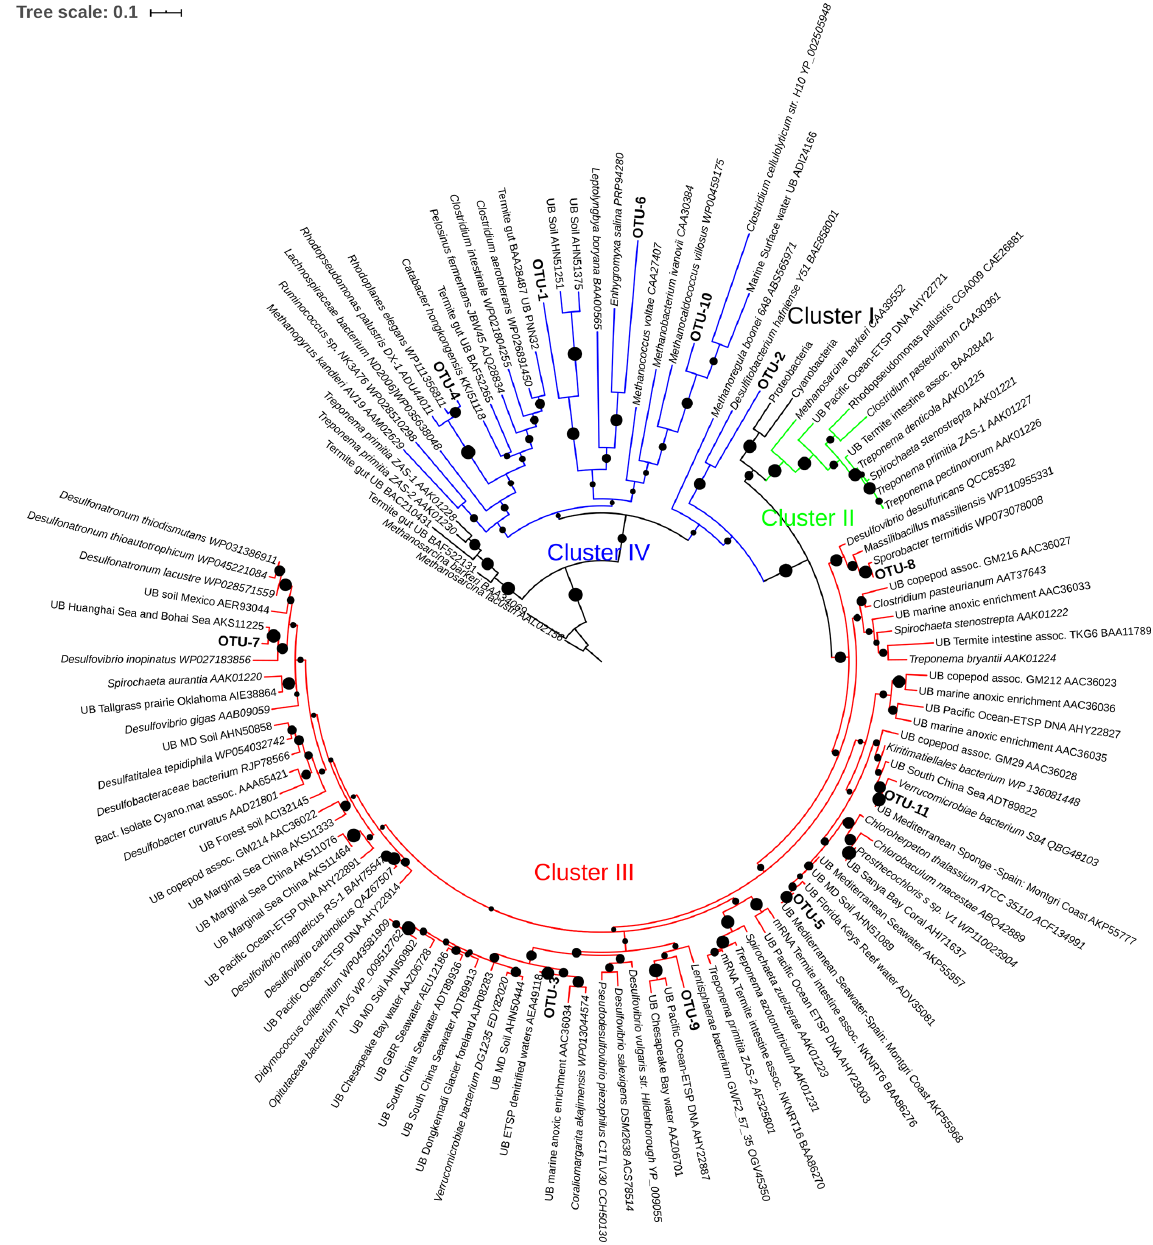
Figure 6. Maximum likelihood (ML) phylogenetic tree, based on the Poisson model, of Cluster II, III, and IV partial nifH -translated amino acid sequences from DNA and cDNA. Bootstrap values > 50% of 1000 replications are labeled with black circles on the branches. Accession number of reference sequences from NCBI are provided at the end of each reference name. Positions of the OTUs are shown relative to their nearest neighbors from the database. Individual sequence identities comprising each OTU are listed in Table